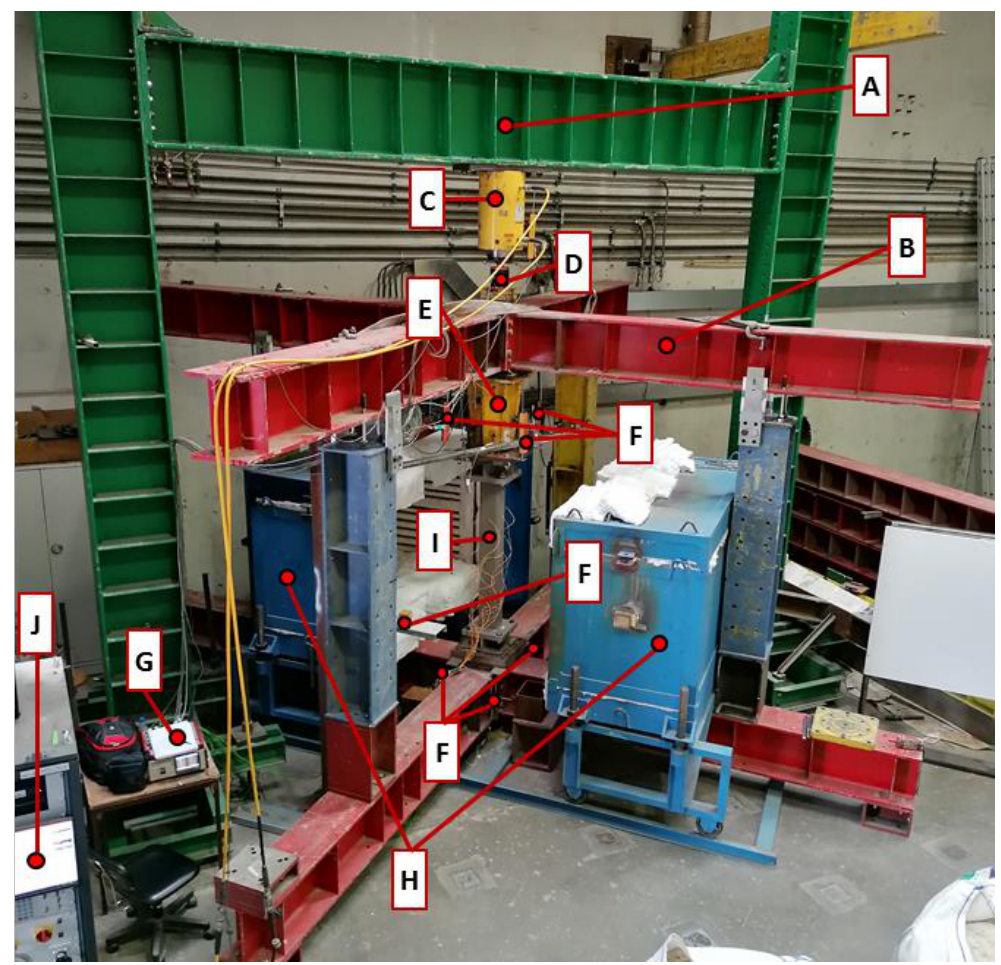
Figure 8. Experimental system used in the laboratory to test SSCS. The letters in this figure are defined in the following text.